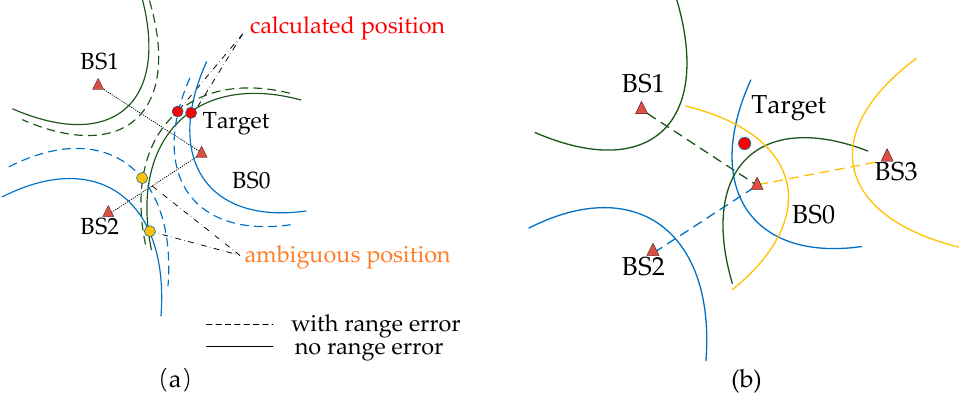
Figure 1. The principle of time difference of arrival (TDoA) measurement. ( a ) The diagram when there are three basic sensors of TDoA. ( b ) Multiple hyperbolas for the optimal position.